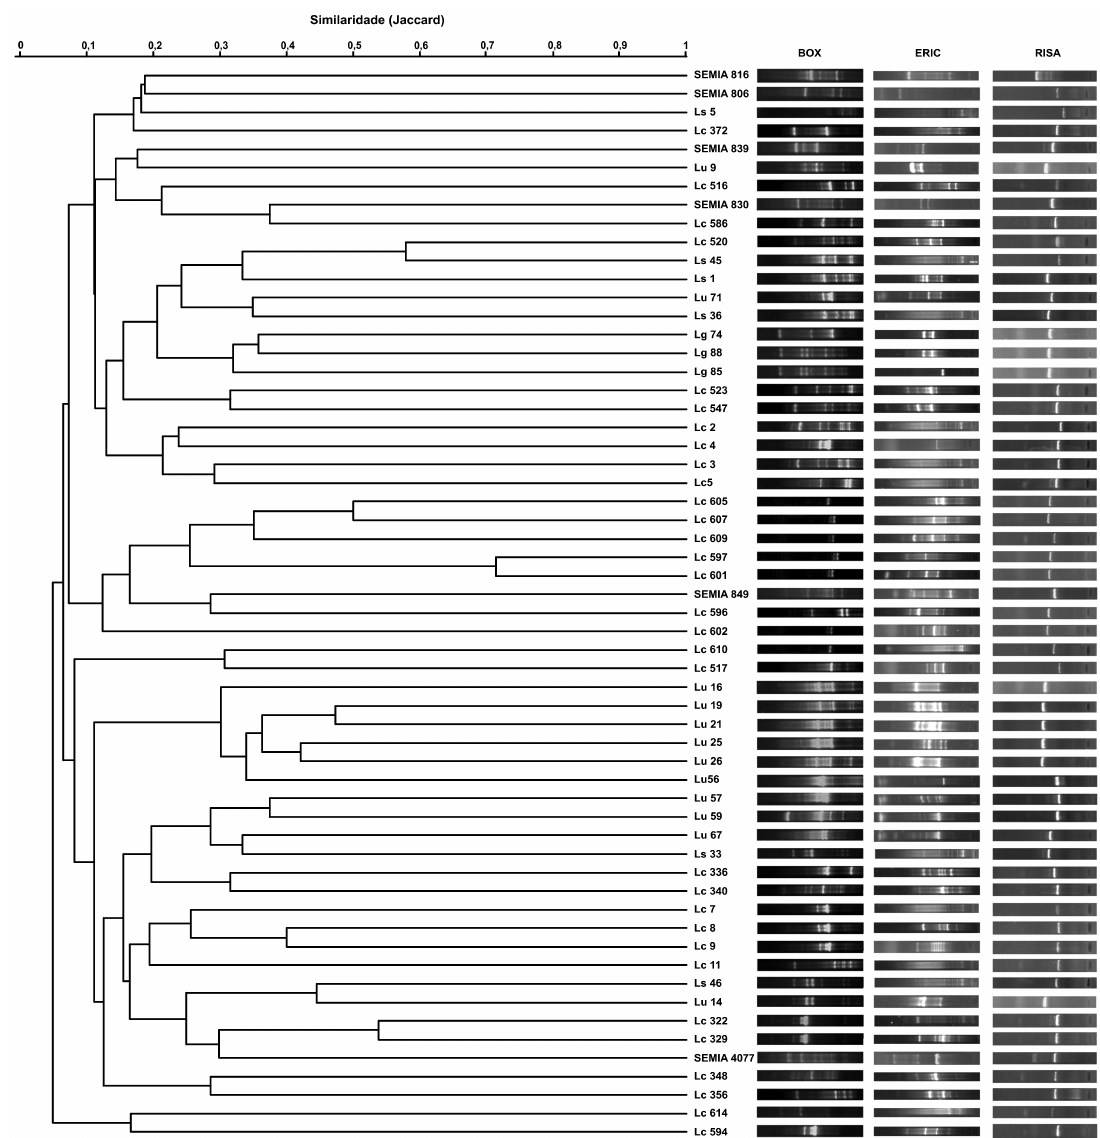
Figura 1. Dendrograma de genotipagem de estirpes e isolados de rizóbios, autóctones em solos do Rio Grande do Sul, simbiontes em quatro espécies de Lotus . Agrupamento obtido pelo coeficiente de Jaccard, para perfil de bandas obtido a partir da PCR com os oligonucleotídeos iniciadores BOX A1-R, ERIC e